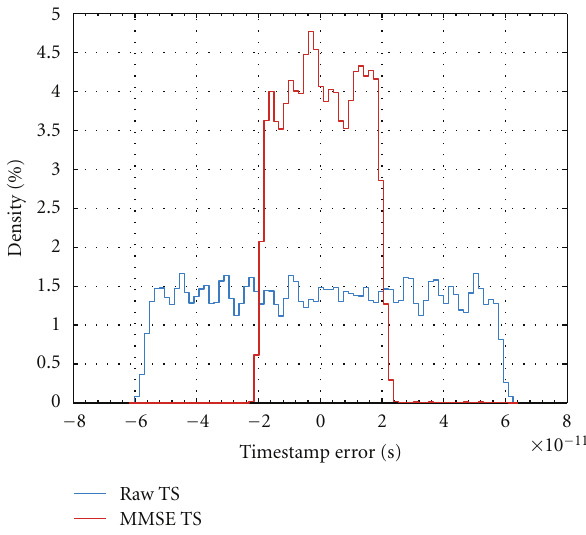
Figure 8: Timestamp error for a combined phase/frequency estimation ( β = 0 : 002; n = 2) with linear MMSE estimator using 128 samples. The histogram shows a total of 50kTS in 75 bins, giving a standard deviation of 12.036